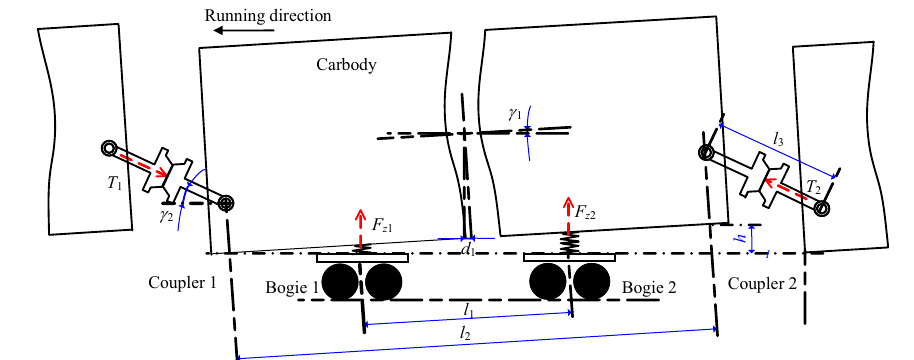
Fig. 6 Quasi-static geometric analyses of train and coupler